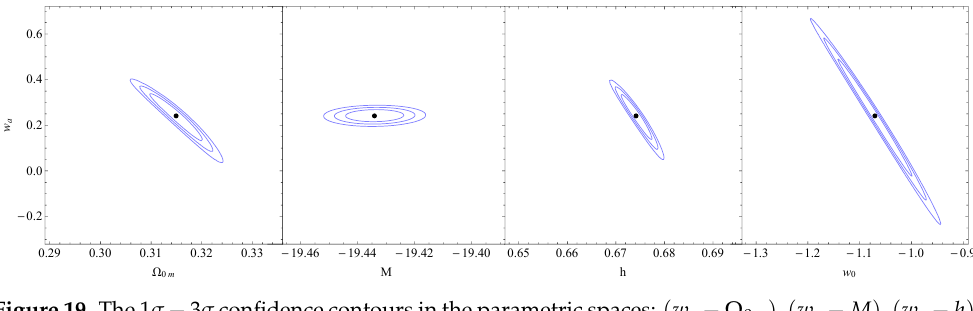
Figure 19. The 1 σ − 3 σ confidence contours in the parametric spaces: ( w a − Ω 0 m ) , ( w a − M ) , ( w a − h ) and ( w a − w 0 ) for the CPL